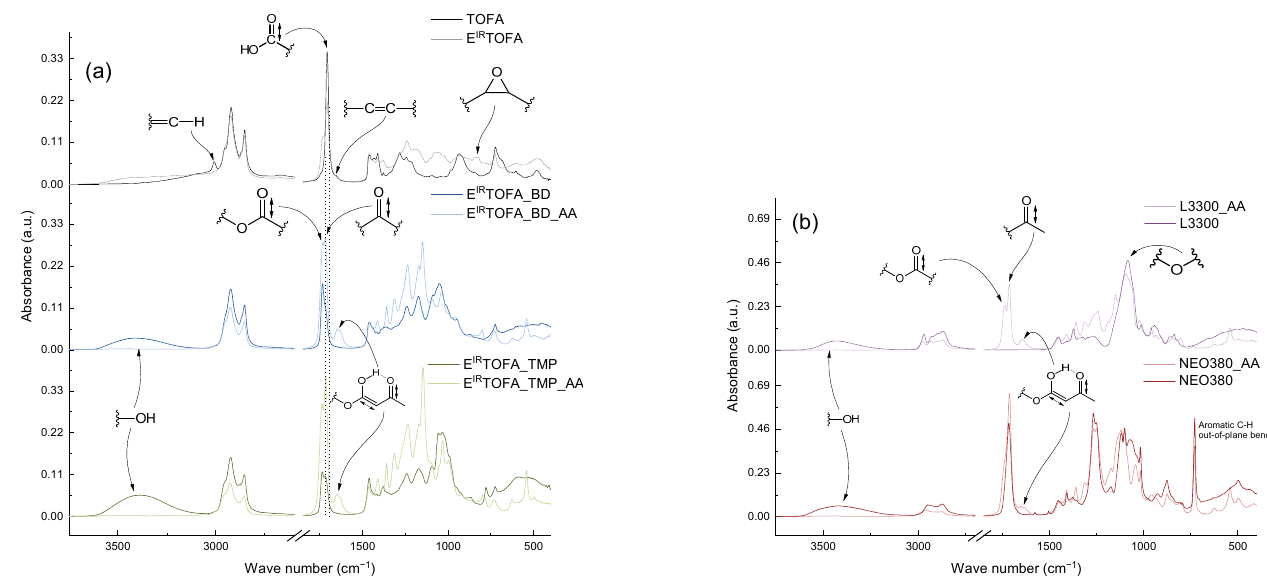
Figure 3. FTIR spectra of TOFA, E IR TOFA, synthesized polyols, commercial polyols and acetoacety- lated polyols: ( a ) based on tall oils; ( b ) based on commercial polyols.